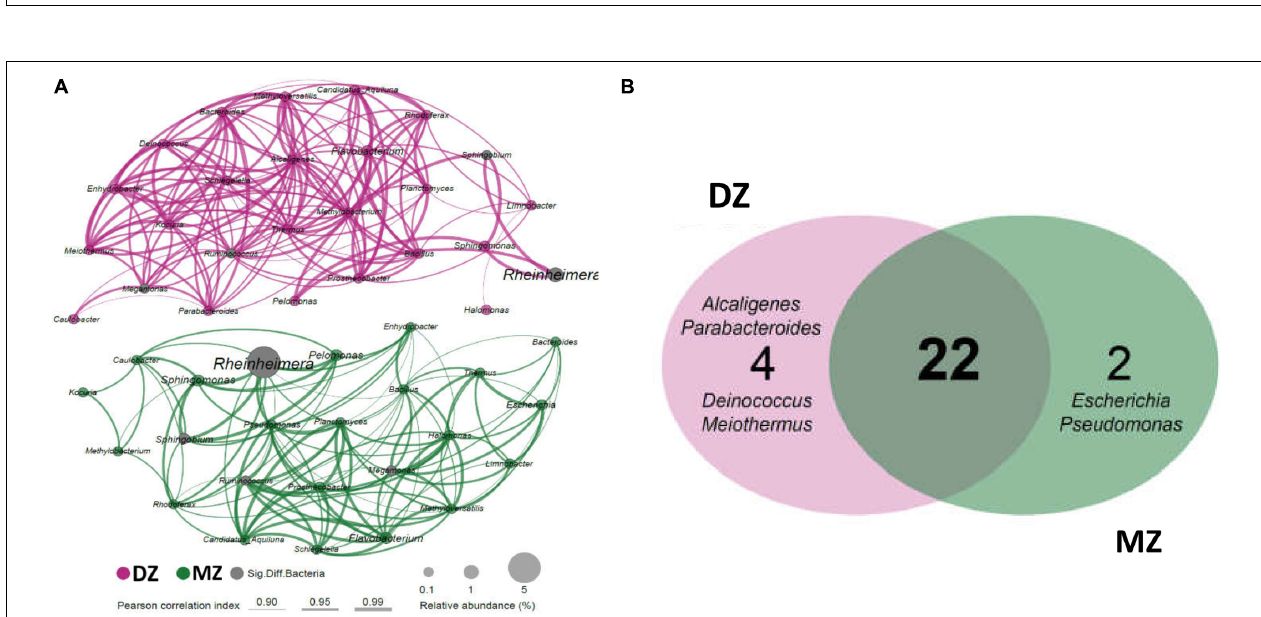
FIGURE 3 | Heatmap (A) and box-plot (B) of the 25 genera with significant different abundance between DZ and MZ. (C) LEfSe analysis between DZ and MZ showing genera with LDA score absolute values > 2.0. Genera that were enriched in DZ or MZ groups were framed in black in the heatmap (A) and they were underlined in different colors in the box-plot (B) .